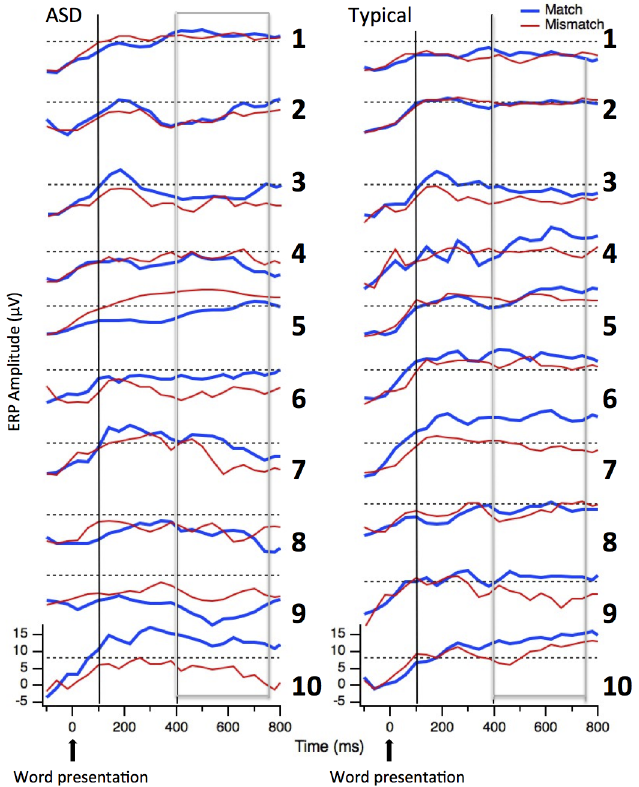
Fig 11. Individual ERP profiles for Auditory Evoked Potentials. Individual ERP waveforms time-locked to the word for the two groups (ASD children on the left and Neurotypical children on the right) and the two conditions (Match in blue and Mismatch in red) in the Vertex array. The vertical lines indicate the expected latency for the auditory P1 peak and the boxes indicate the time-window where the N400 component is